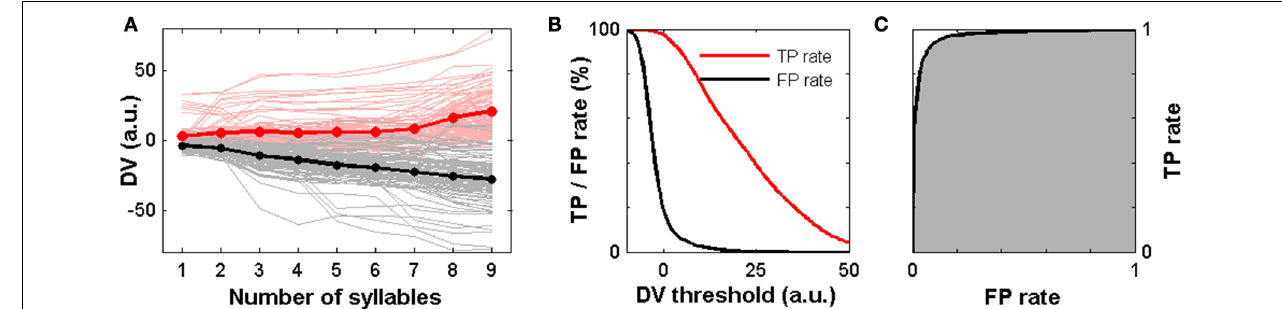
FIGURE 7 | A model of decision making based on the experimental spike trains. (A) The DV as a function of the song syllables for 100 presentations of an attractive song (perturbed at the beginning of each syllable) are shown as light red lines. The average (red line) is computed across all possible combinations of 8 neurons and all trials. It signifies an overall increase over time. The single trial DV for 100 unattractive song